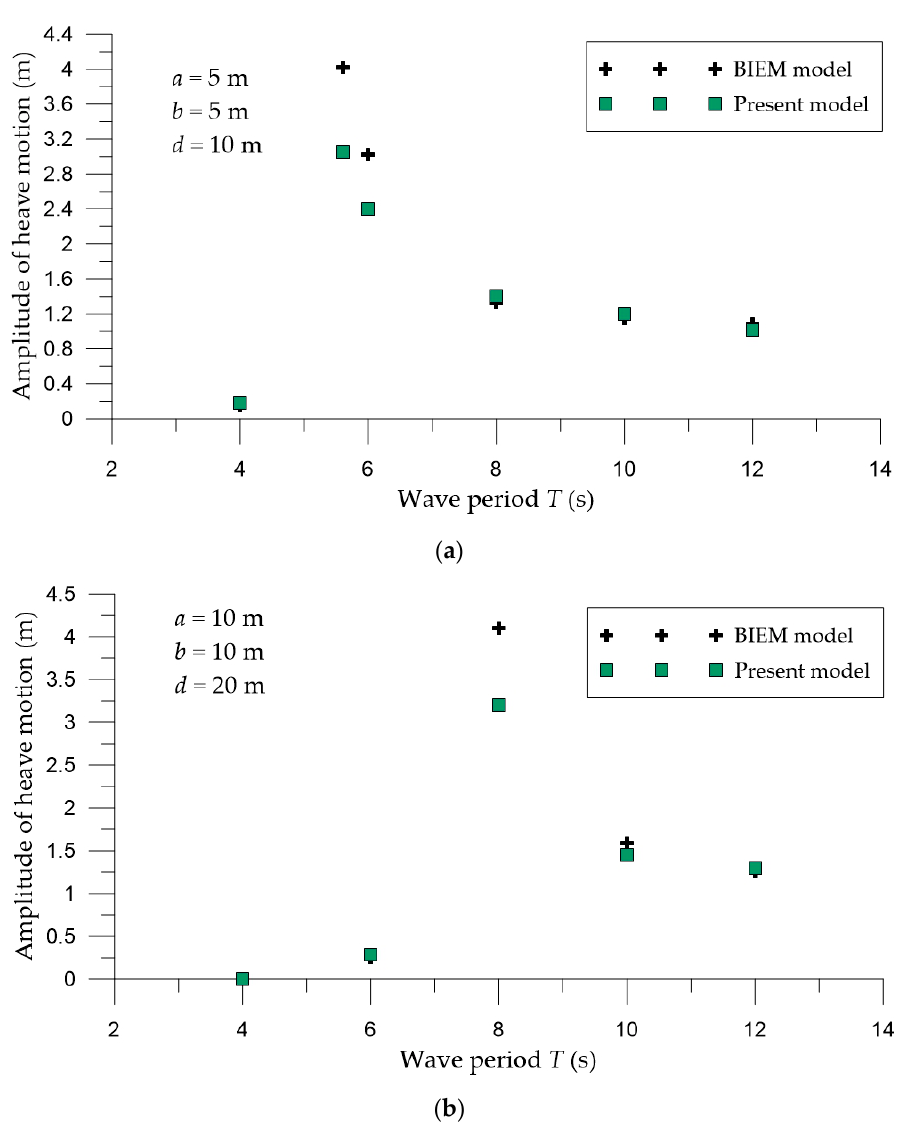
Figure 5. Amplitude of the cylinder’s heave motion under regular waves: ( a ) a = 5.0 m and b / a = 1.0 ( d = 10.0 m); ( b ) α = 10.0 m and b / a = 1.0 ( d = 20.0 m).